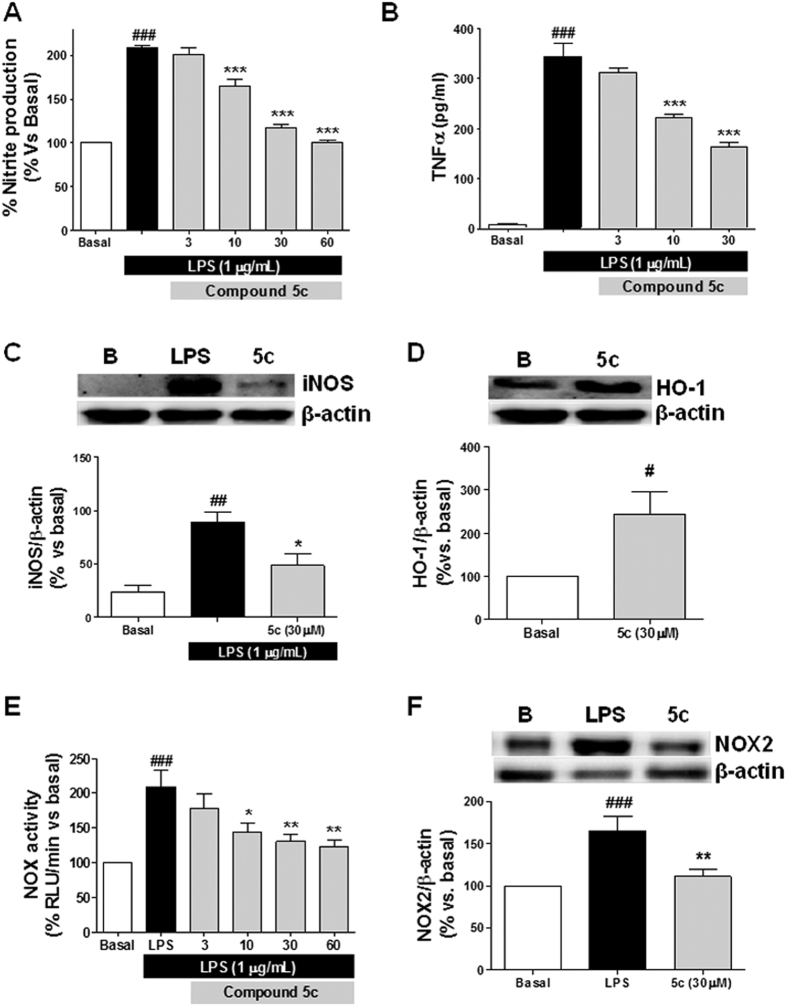
Nitrites (A), TNFα (B), iNOS (C) and NOX activity (E) blockade (D) and NOX2 production (F) by 5c in primary glial cultures stimulated with LPS (1 μg/mL), HO-1 expression induced by this compound after 24 h. Primary glial cells cultures were treated with compound 5c at increasing concentrations (3, 10, 30 and 60 μM) for 24 h, thereafter, treatments were removed and glial cells were co-incubated with compound 5c at increasing concentrations and LPS (1 μg/mL) for 18 h more. To measure NOX2 and HO-1 expression glial cultures were treated with compound 5c (30 μM) for 24 h. NOX activity was measured after 4 h co-treatment with LPS and compound 5c. Data are means ± SEM of four different experiments in triplicate. ###p < 0.001 compared to basal levels; ***p < 0.001; **p < 0.01; *p < 0.05 compared to LPS condition.